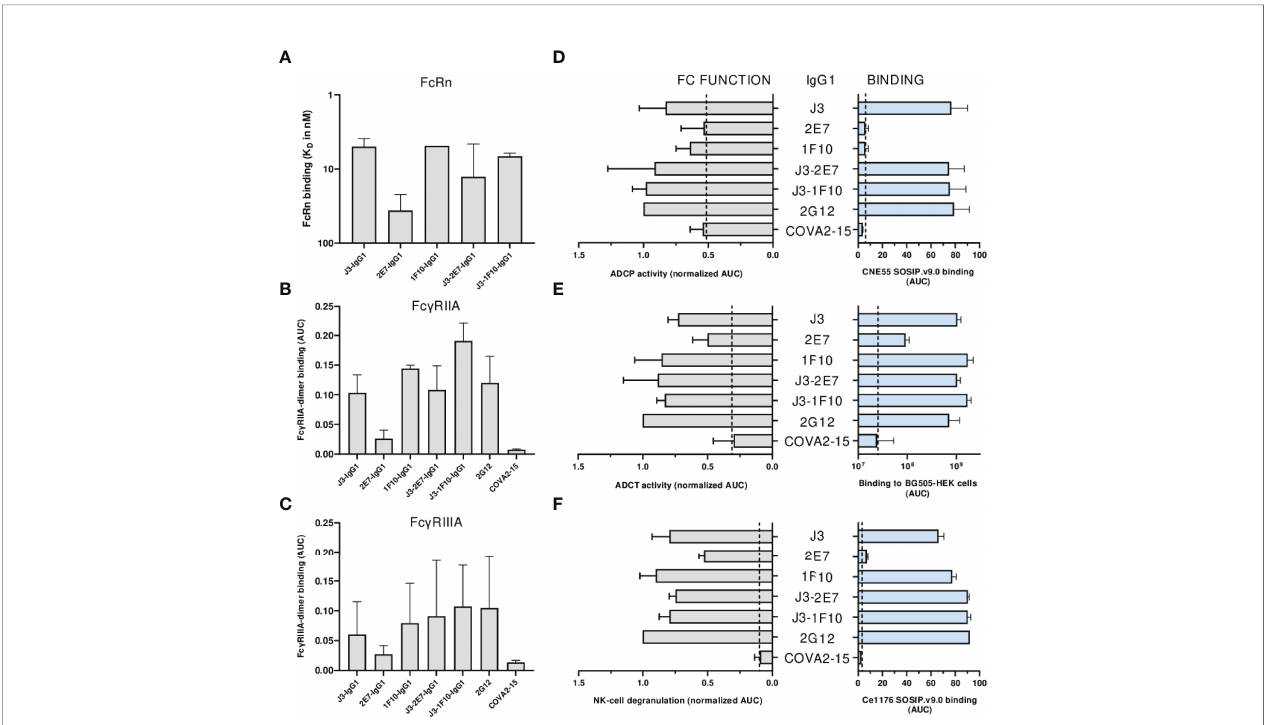
FIGURE 6 | Neutralization is impacted by nanobody-IgG1 fusion. (A) The K D of all nanobody-IgG1s to hFcRn, recorded at pH 6.0 using surface plasmon resonance. K D was calculated as the average K D from multiple antibody concentrations as seen in Supplementary Figure 5 . Binding of nanobody-IgG1s to (B) Fc g RIIa and (C) Fc g RIIIa as determined by Fcg g R dimer ELISA using Ce1176 SOSIP.v9.0 as coating antigen, depicted as AUC values of the binding curves. (D) Binding of nanobody-IgG1s to CNE55 SOSIP.v9.0 as determined by ELISA and induction of ADCP using CNE55 SOSIP.v9.0 coated fl uorescent beads, both depicted as AUC. (E) Binding of nanobody- IgG1s to BG505 gp160 expressing HEK-293T cells and induction of ADCT are quanti fi ed by a secondary PE-labeled anti-IgG antibody and uptake of membrane fragments by THP-1 cells using fl ow cytometry, both depicted as AUC. (F) The binding strength for all nanobody-IgG1s to Ce1176 SOSIP.v9.0 as determined by ELISA and subsequent activation of NK-cells plotted as the percentage of CD107+ NK-cells. 2G12-IgG1, speci fi c for HIV-1 gp120, was used as a positive control and COVA2-15, speci fi c for SARS-CoV-2, was used as a negative control. The dotted lines represent the background level that is observed in these assays in the absence of antibody. Effector function data is normalized to the positive control, 2G12. Data shown are the average of at least two independent